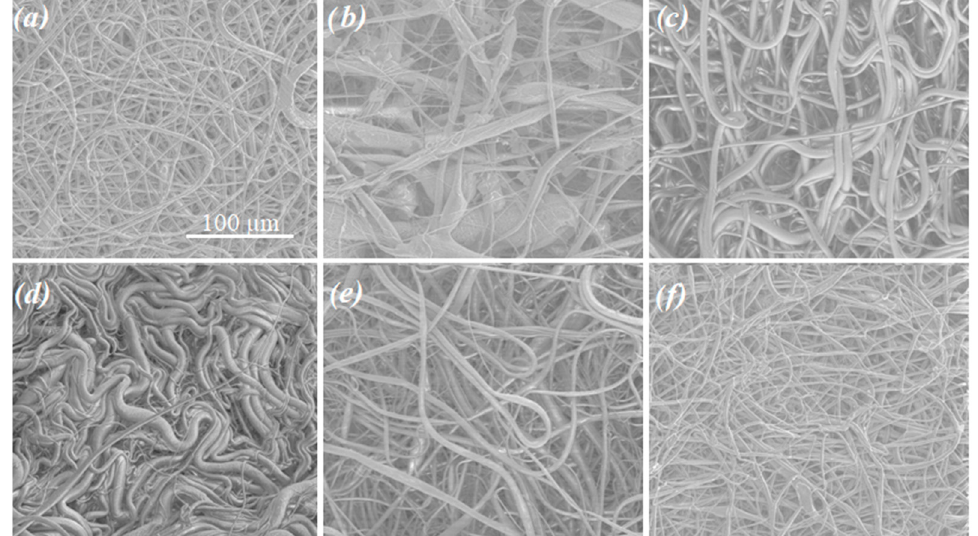
Figure 3. SEM micrographs of drug-loaded nonwoven patches; ( a ) PGCL/PLGA + CTX, ( b ) (PGCL/PLGA) + DTX, ( c ) (PLTMC/PLGA) + DTX, ( d ) PLGCL + DTX, ( e ) PLGA + DTX, ( f ) drug- free PGCL/PLGA after fast degradation scan (14 days of incubation in PBS pH = 7.4 and 37 °C). On the basis of a 14-day degradation scan and drug release (PGCL/PLGA) + CTX and PLGCL + DTX patches were selected for further long-term verification.